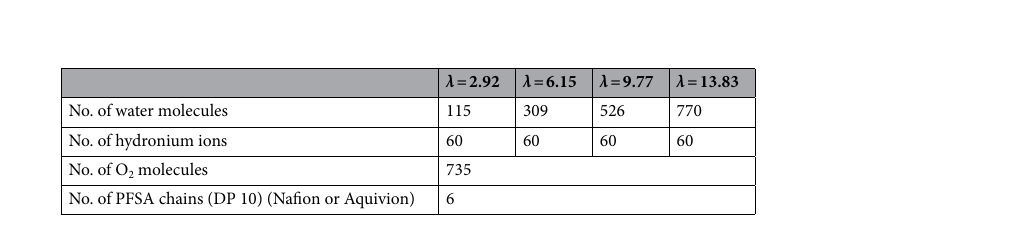
Table 1. Details of parameters for the MD simulations.